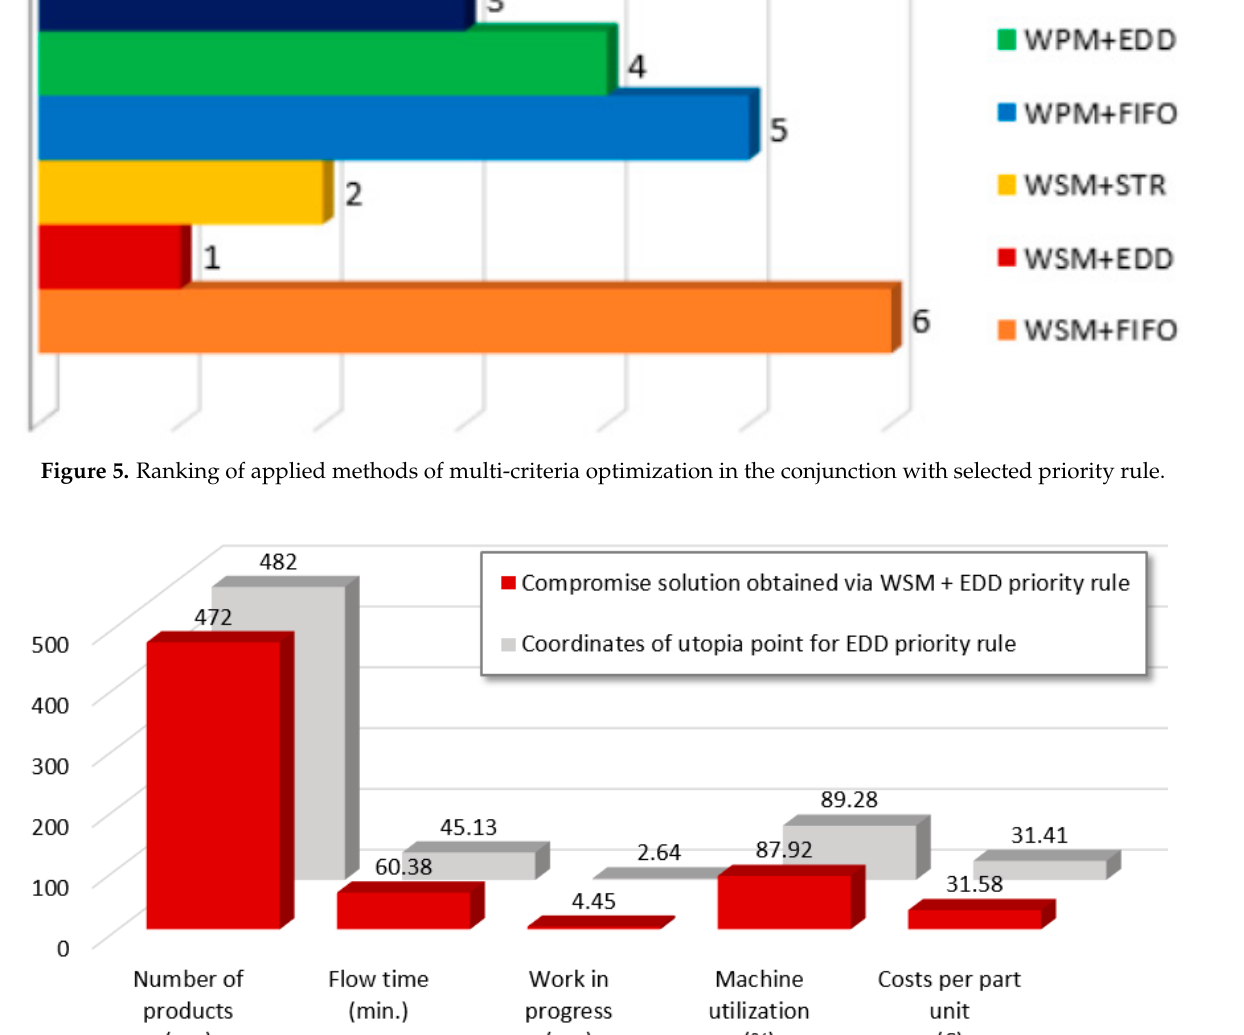
Figure 6. The comparison of coordinates of the ideal point for the EDD priority rule and the best evaluated compromise